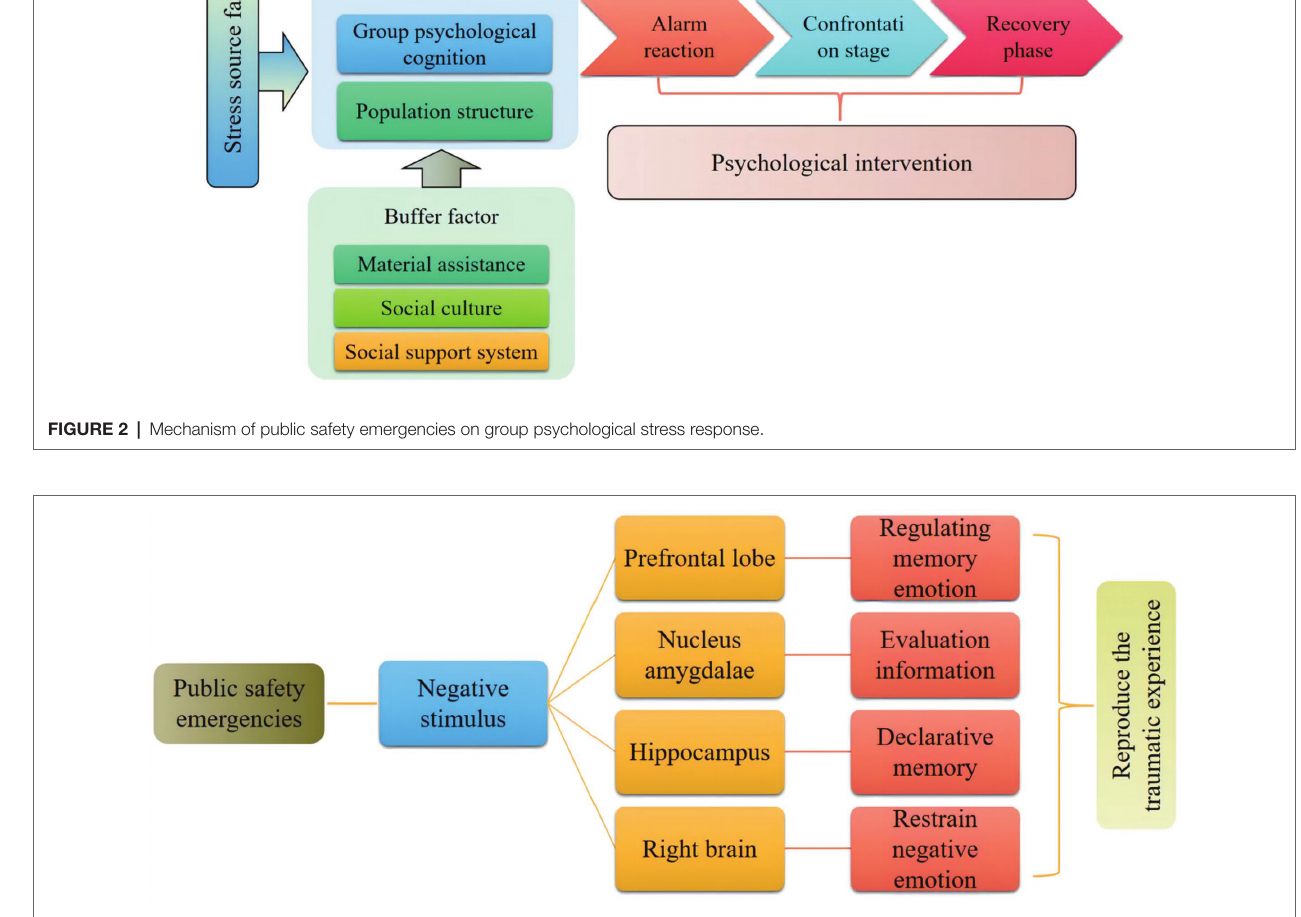
FIGURE 3 | Action mechanism of public safety emergencies on individual